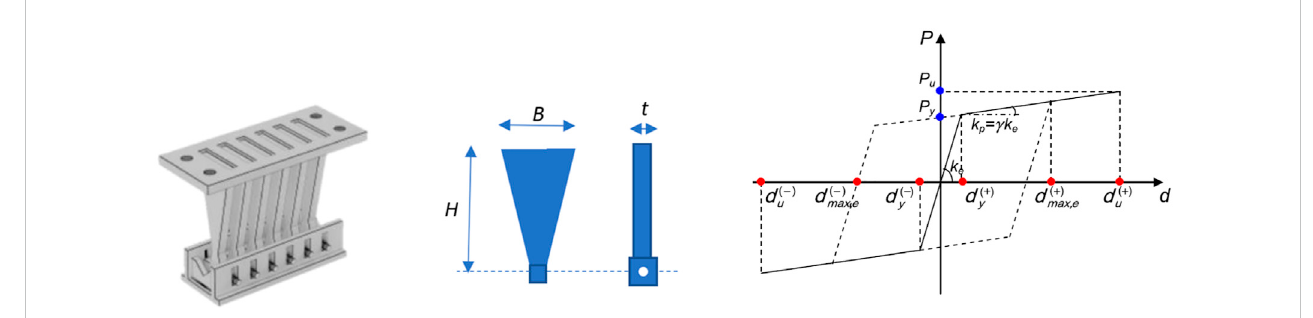
FIGURE 1 Drawing of a T-ADAS damper, and geometry and idealized horizontal force-displacement response cycle of a constituting